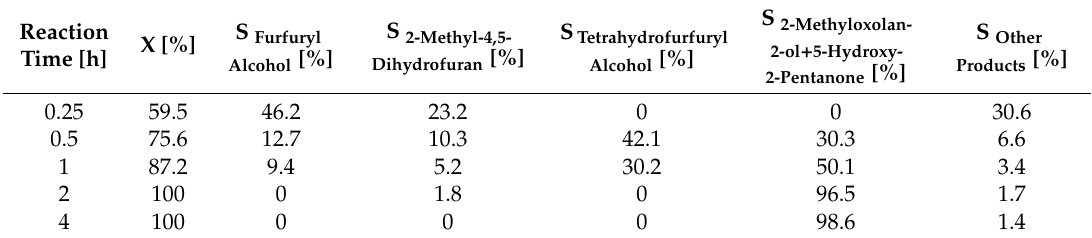
Table 2. The influence of time on conversion degree of furfural (X, %) and selectivity to all products (furfuryl alcohol, 2-methyl-4,5-dihydrofuran, tetrahydrofurfuryl alcohol, and 2-methyloxolan-2-ol) in the furfural reduction in water phase over 5%Pd-1%Au/SiO 2 catalyst.